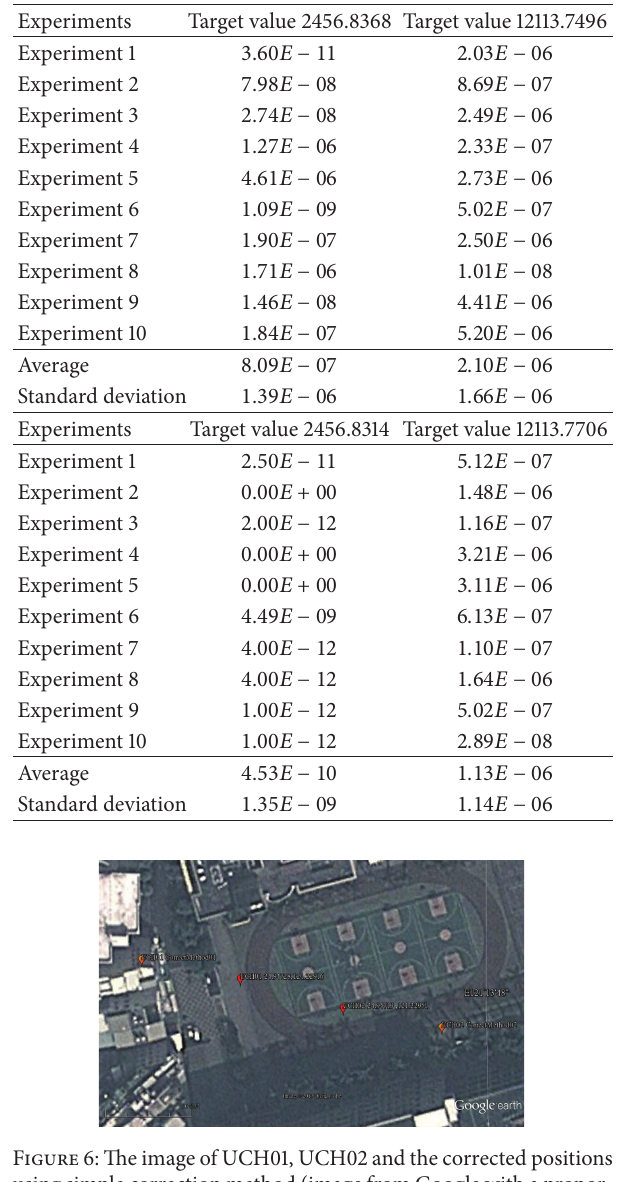
Table 5: Training time (in second).